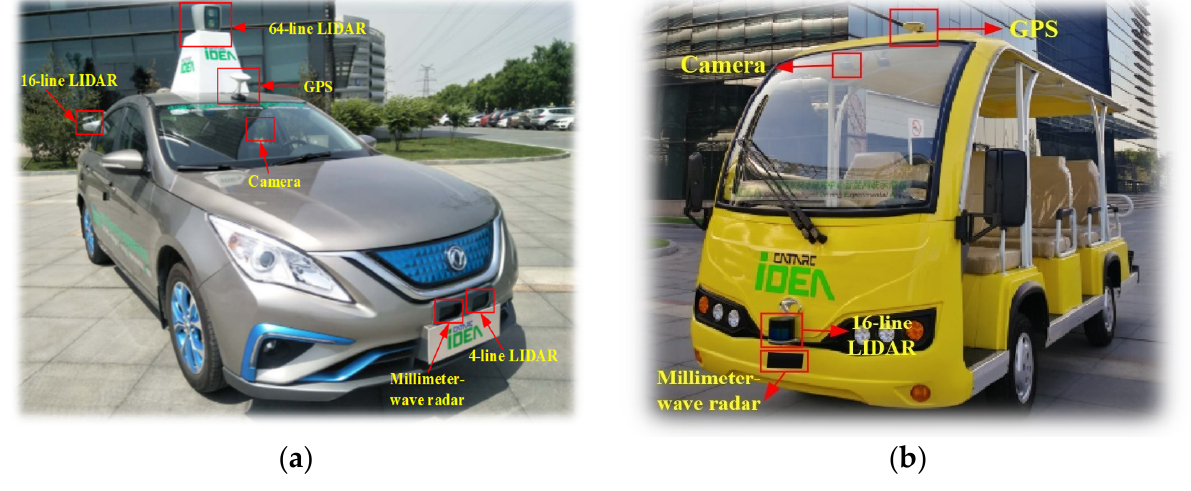
Figure 8. ( a ) Dongfeng S50 EV. ( b ) Sightseeing vehicle.